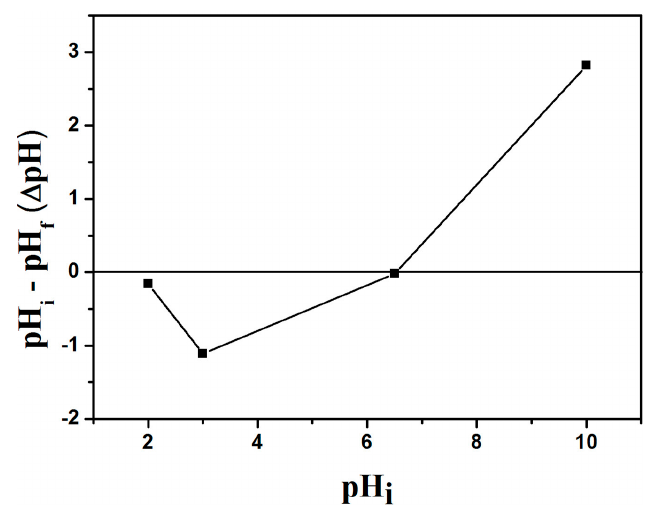
Figure 5. Point of zero charge of GO(20)/cellulose(100) hydrogel.